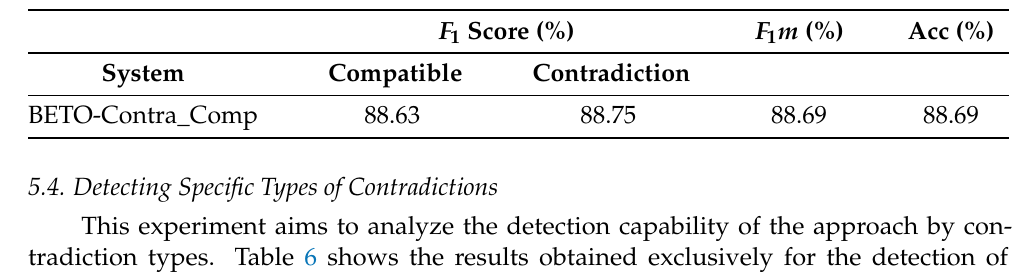
Table 5. Results obtained from Experiment 3: Detecting between compatible and contradictory information when the texts are related.